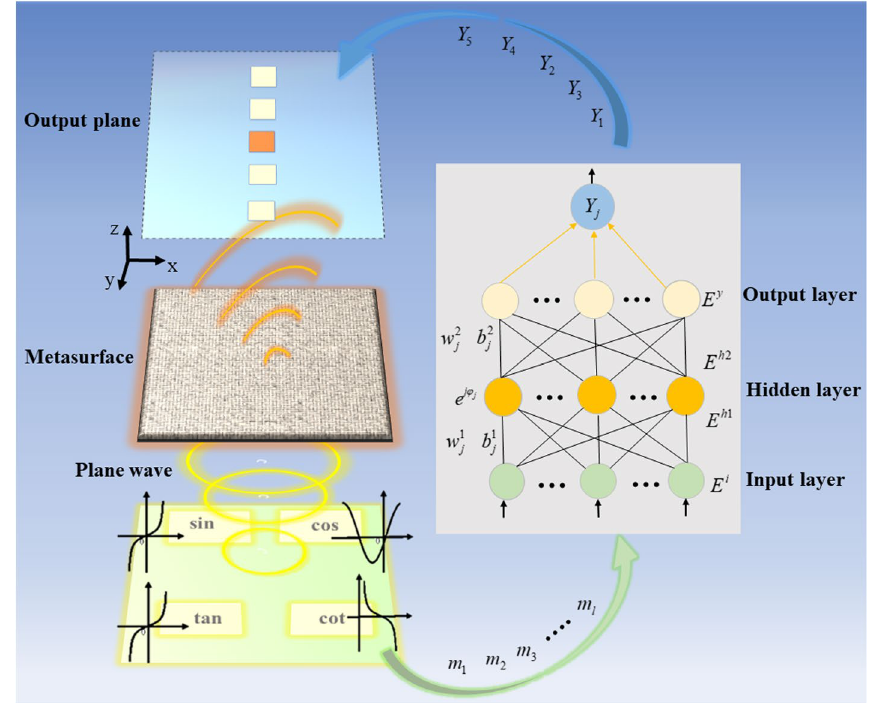
Fig. 1 The conceptual representation of the designed optical trigonometric